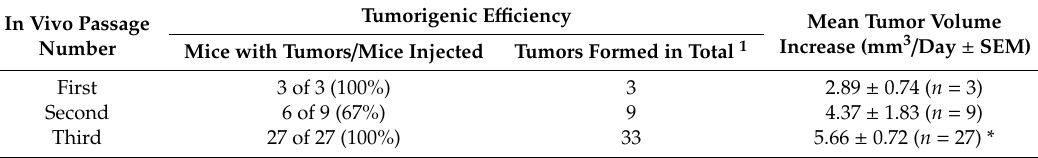
Table 1. Serial xenotransplantation of NSTS-11 cells in NSG mice. A total of 3 × 10 5 parental NSTS-11 cells or cultured cells derived from the xenograft tumors obtained in a previous in vivo passage were subcutaneously injected into the